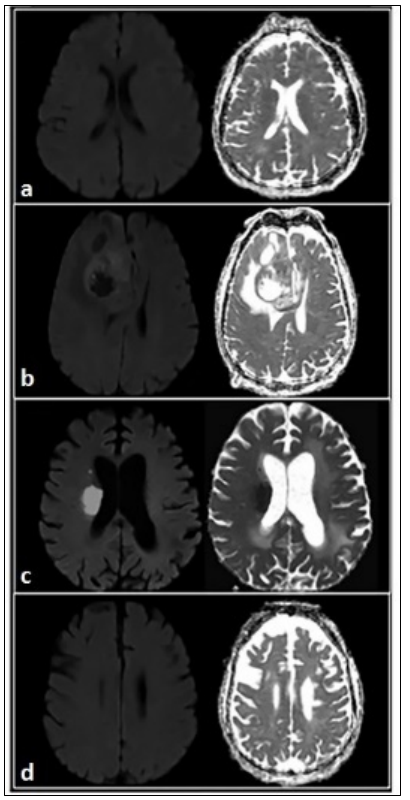
Figure 1. DWI technique. Restriction in diffusion (decreased ADC) occurs when there is a narrowing of the extracellular space due to an increase in cellular density caused by tumour growth ( b ) or cytotoxic edema with cellular swelling caused by acute brain ischaemia ( c ). Conversely, the increase in extracellular space promoted by vasogenic edema, demyelination ( a ), gliosis ( d ), or axonal loss, results in an increase in